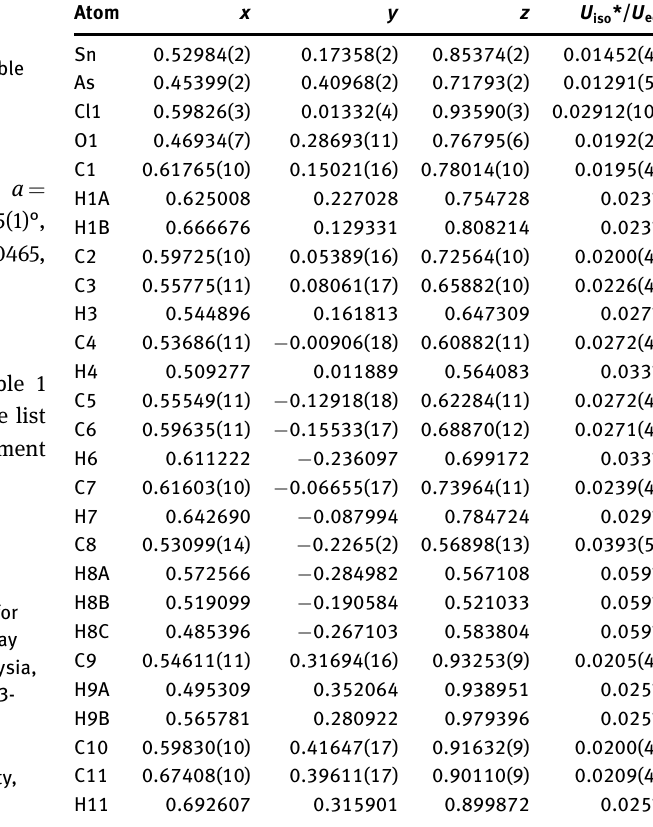
Table 2: Fractional atomic coordinates and isotropic or equivalent isotropic displacement parameters (Å 2